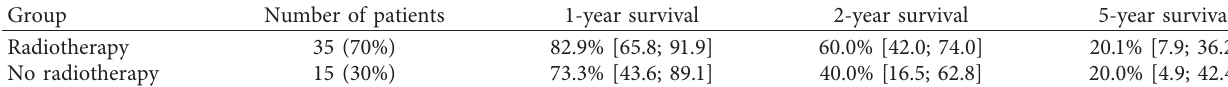
Table 7: Survival results of the patients treated by radiotherapy.